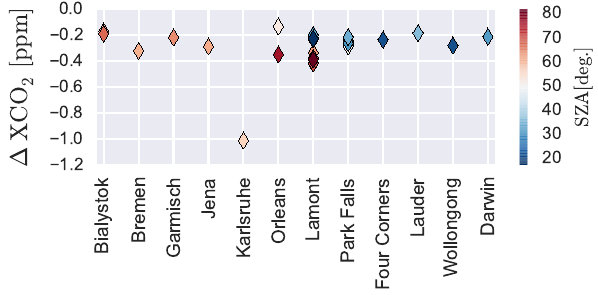
Figure 8. Differences in XCO 2 if the Karlsruhe retrieval strategy is applied to data of all TCCON stations which contribute to the XCO 2 aircraft calibration curve. Corresponding solar zenith angles (SZA) of the particular measurement are color coded.